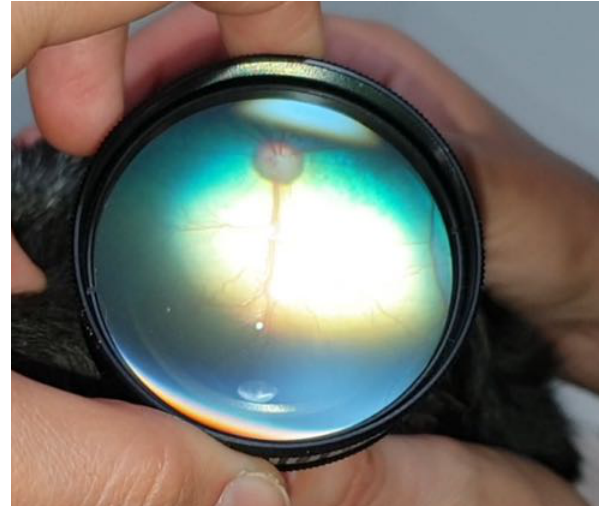
Figure 12. Indirect ophthalmoscopy using a 30 D Volk lens- note the optic disc at the top with the retinal vessels, tapetal fundus at the bottom (the image is inverted in indirect ophthalmoscopy) North Downs Specialist